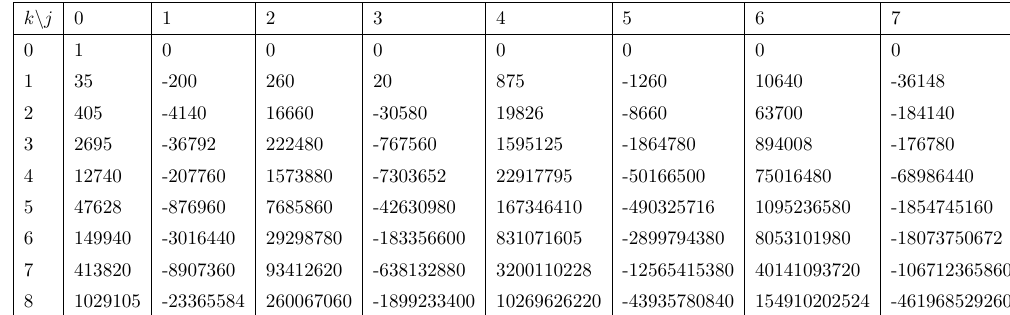
Table 33. Table of b jk coe(cid:14)cients for h SU(6) (cid:3)